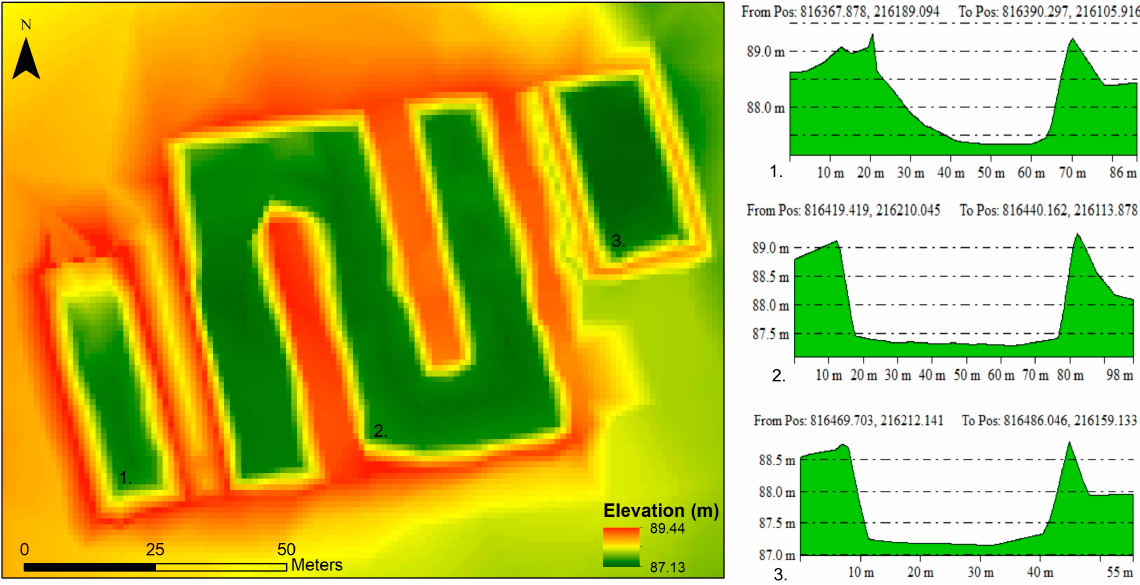
Figure 3. Digital elevation model of the liquid waste disposal and longitudinal cross sections of the